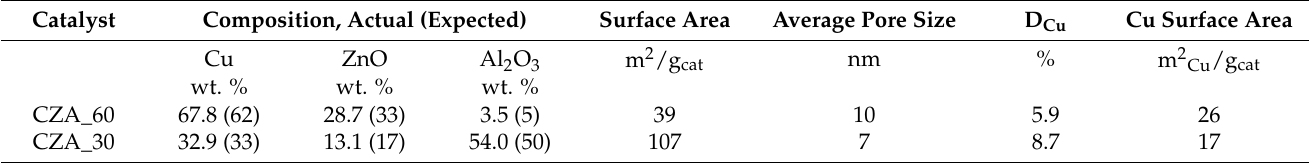
Table 1. Composition (ICP-OES), surface area (BET), Cu dispersion, and copper surface area (N 2 O chemisorption) of the catalysts. Catalyst